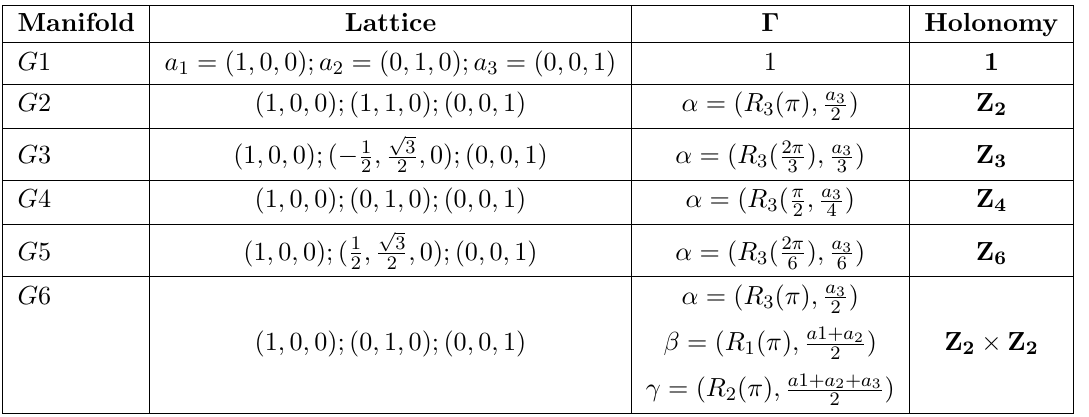
Table 2 . Compact, orientable (cid:13)at